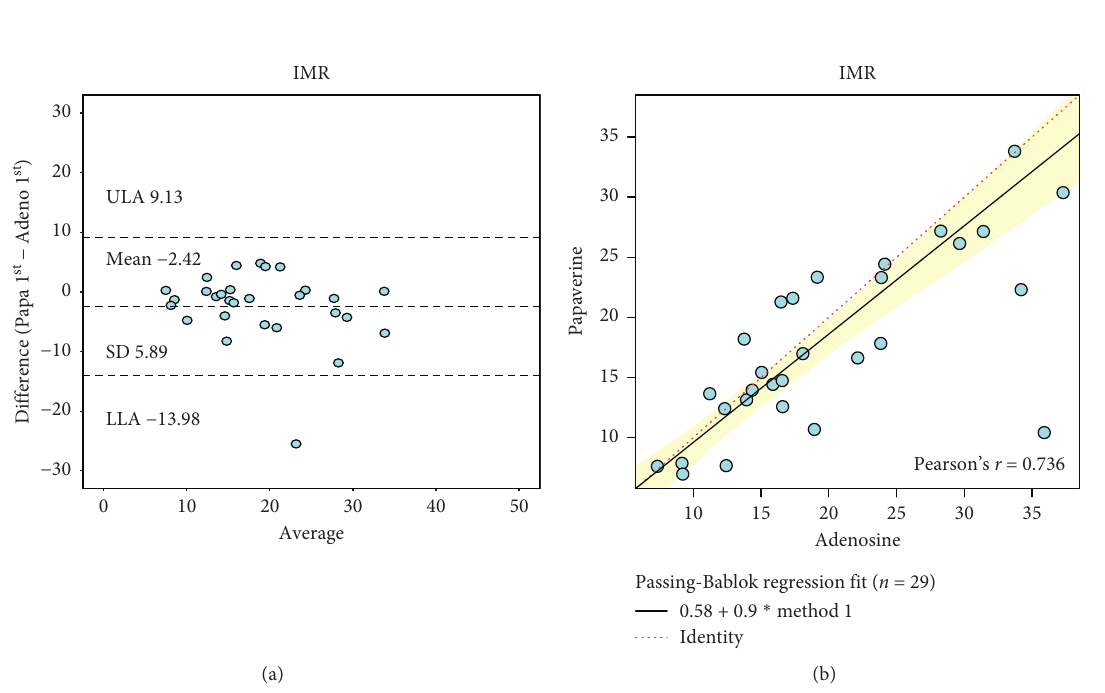
Figure 1: Agreement on IMR between papaverine and adenosine. (a) Bland–Altman plot of IMR measured with papaverine and adenosine. (b) Passing-Bablok regression of IMR measured with papaverine and